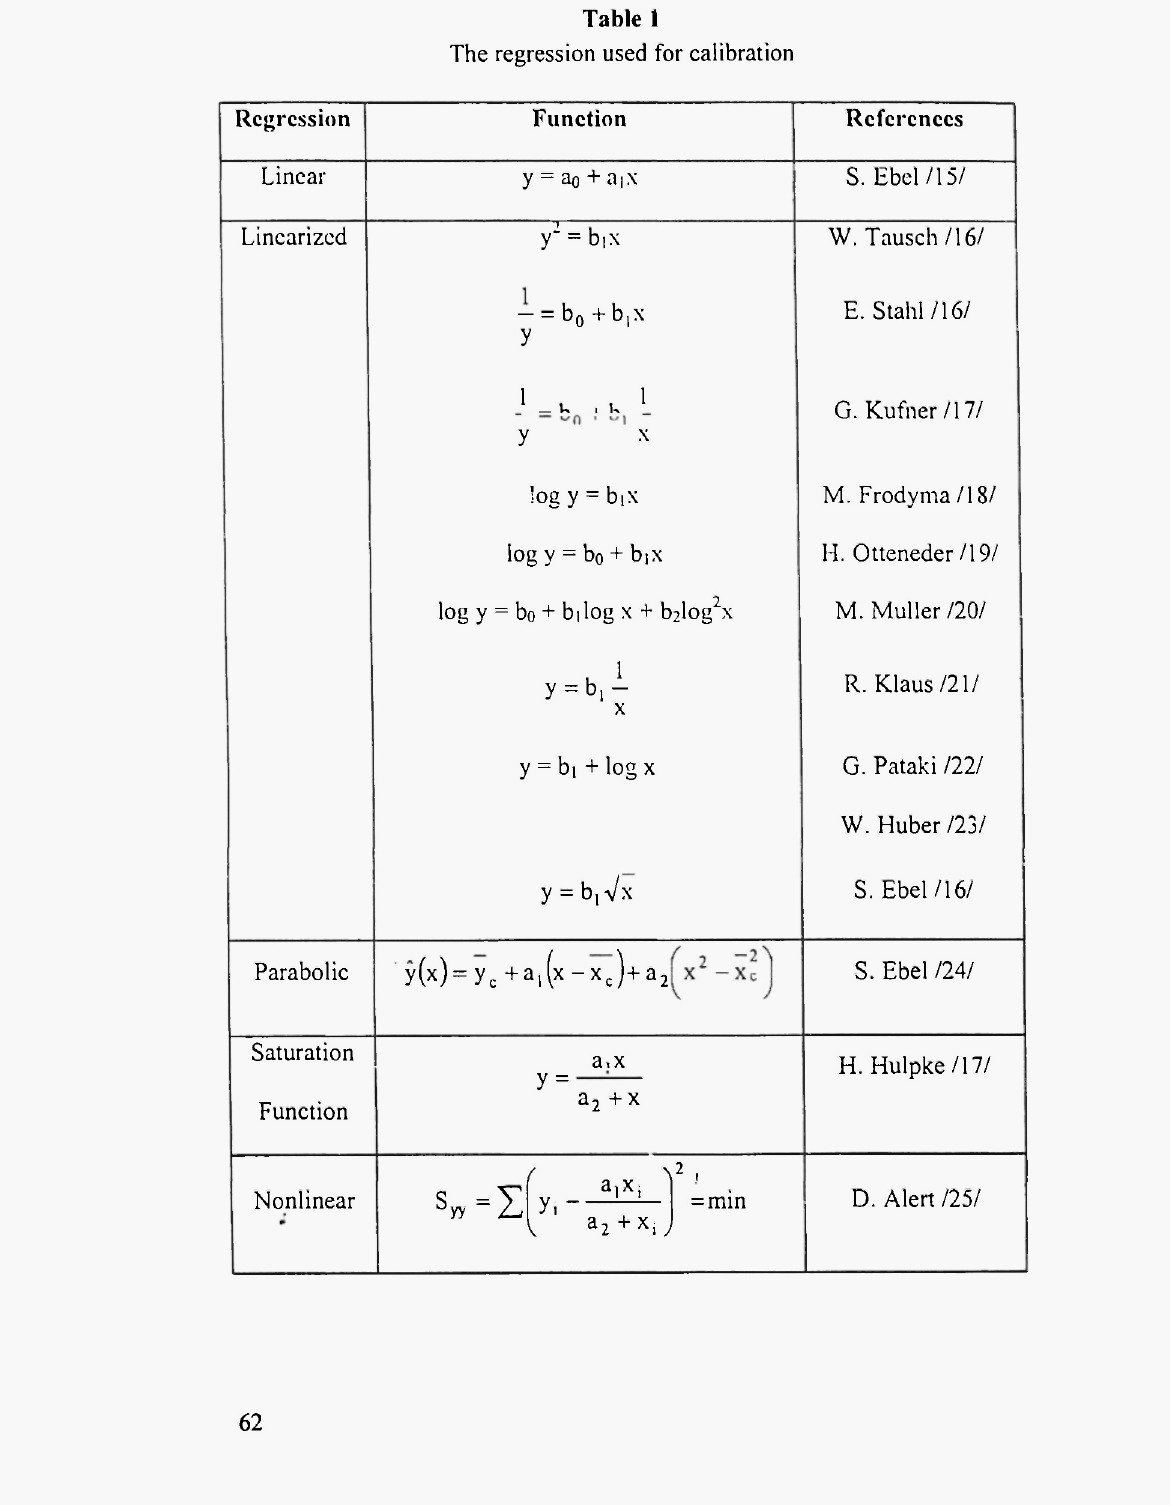
The regression used for